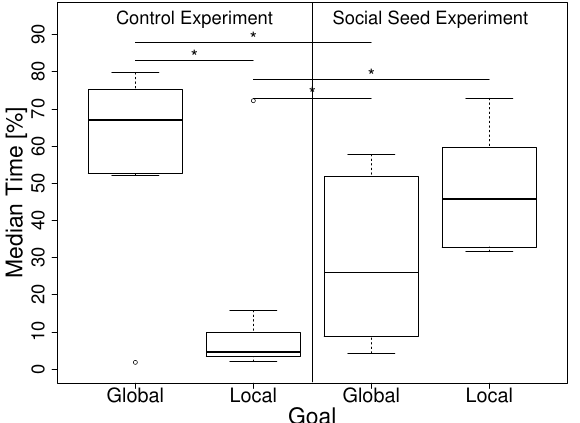
Figure 7: Median time the robots spent in the re- spective optimum area. Left: Control experiment with 10 robots. Right: Experiment with an immo- bilized agent placed in the local optimum area . As- terisks indicate significant differences with p < 0 . 05 .